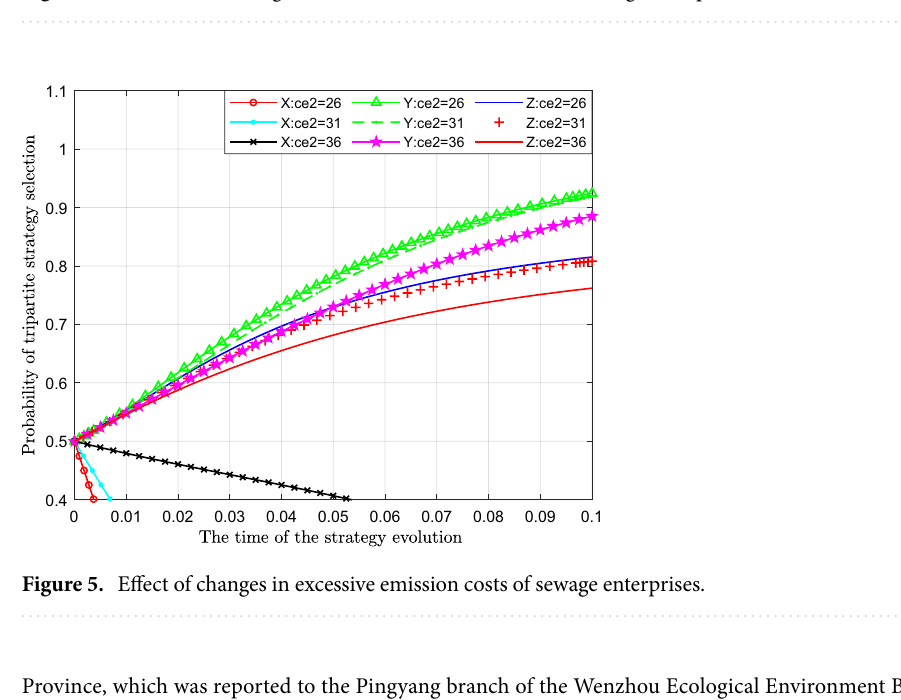
Figure 4. Effect of the change in the standard emission cost of sewage enterprises.